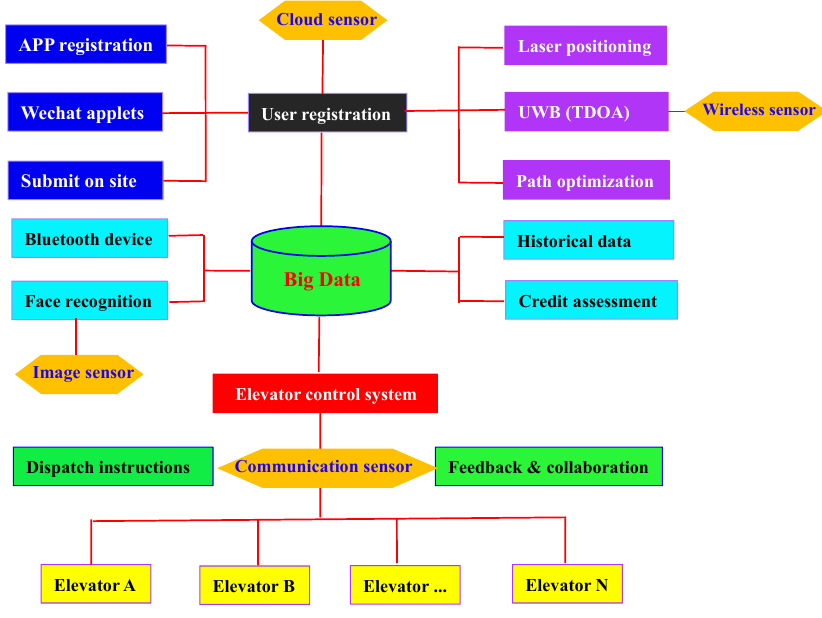
Figure 5. Multi-sensor data connection and functional of booking